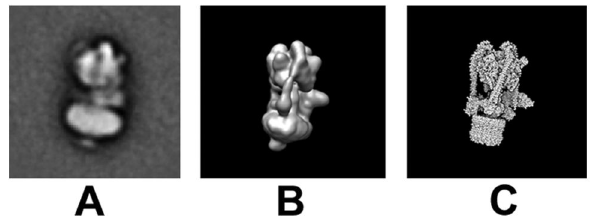
Figure 6. Comparisons between the NMA models and negative stain classes. ( A ) Negative stain class of M . sexta V-ATPase showing the maximum flexing between V relative to each other. A view of the molecular dynamic simulation in the most “flexed” state of M . sexta V-ATPase as a map representation (B) and atom representation (C) shown in the same orientation as (A) with the equivalent flexing of V relative to V o